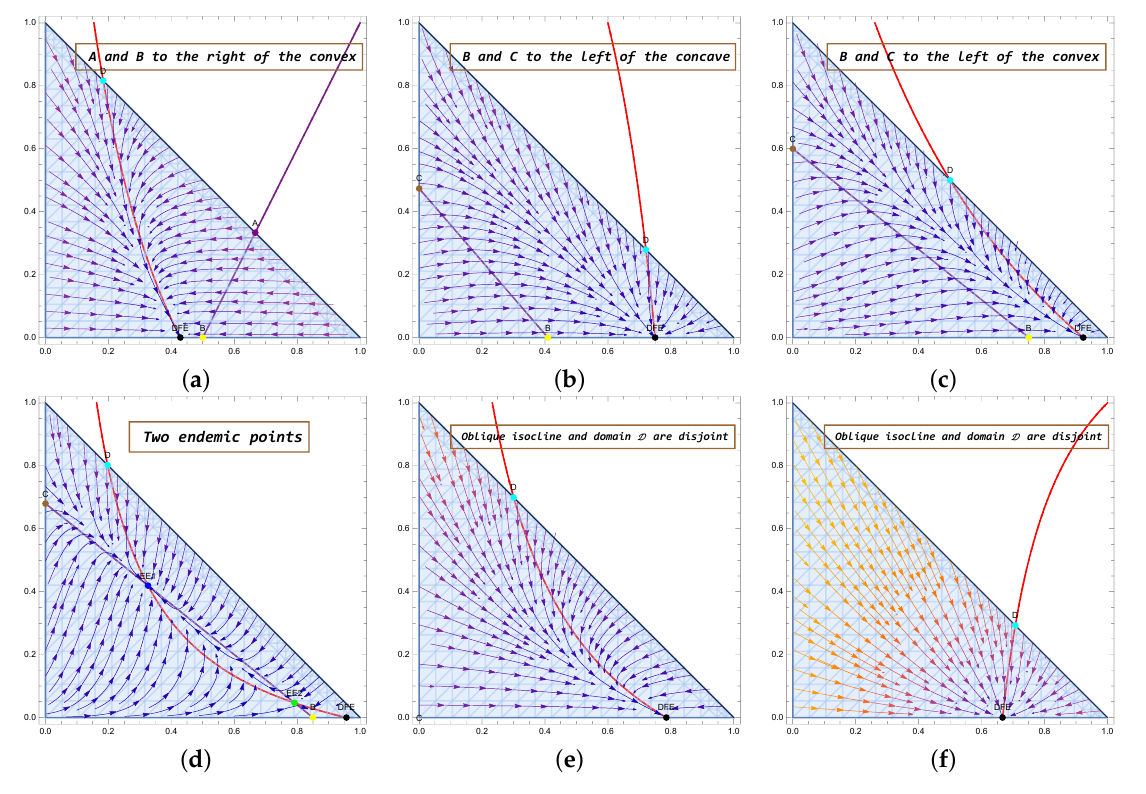
Figure 4. Stream plots of ( s , i ) when γ s > 0, in six cases when R 0 < 1. The DFE is the only stable sink in the boundary of the domain, with the exception of case (d), when EE1 = (0.313823,0.428942) is a second sink, and EE2 = (0.799177,0.0406582) is a saddle point. ( a ) R 0 = 0.952381 < 1, β